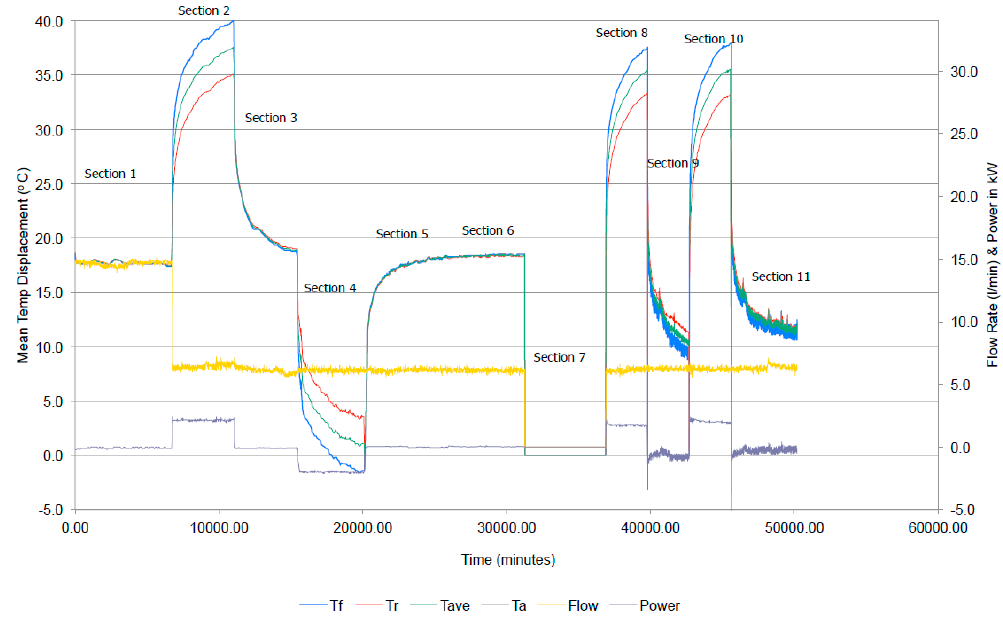
Figure 6. Thermal Response Test (TRT) data recording for the Shell Centre energy pile.